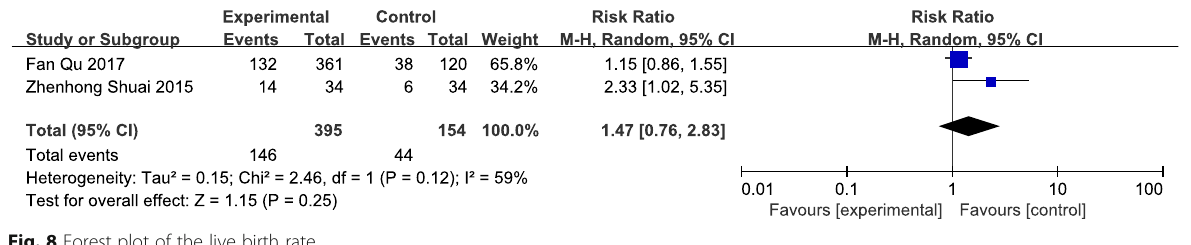
Fig. 8 Forest plot of the live birth